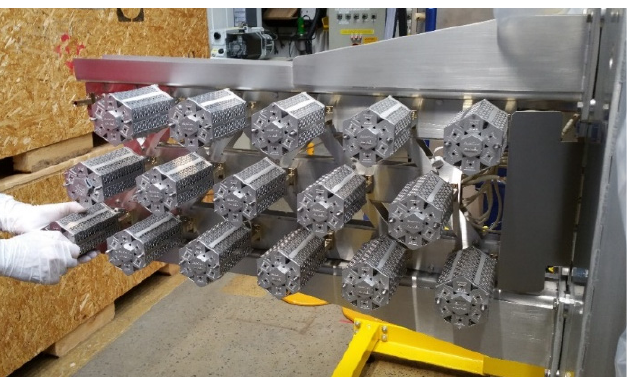
Figure 4. Full NEG pump assembled at the TIMO (test facility for the ITER model pump). The main flange is ready for